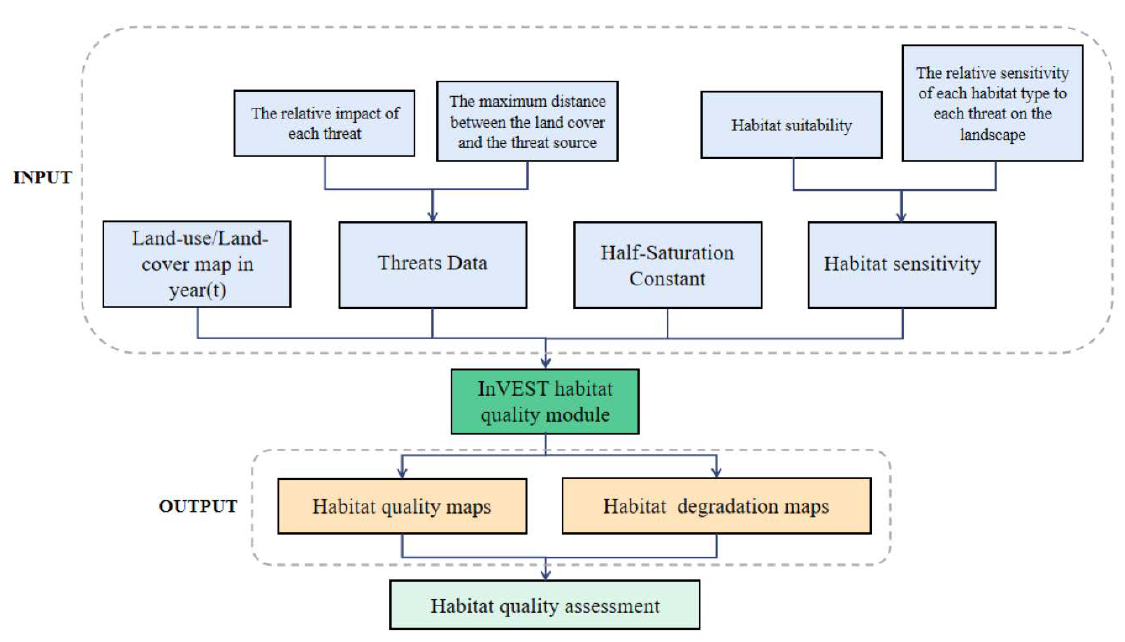
Figure 5. Working framework of InVEST habitat quality module, t stands for the study